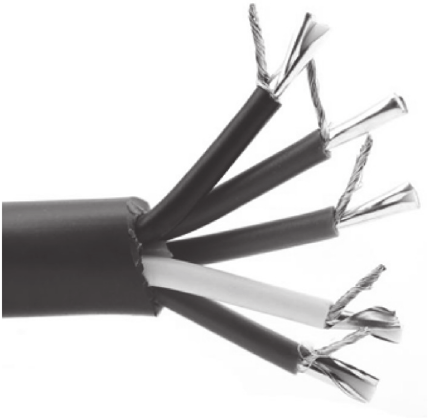
Figure 4: Grayscale